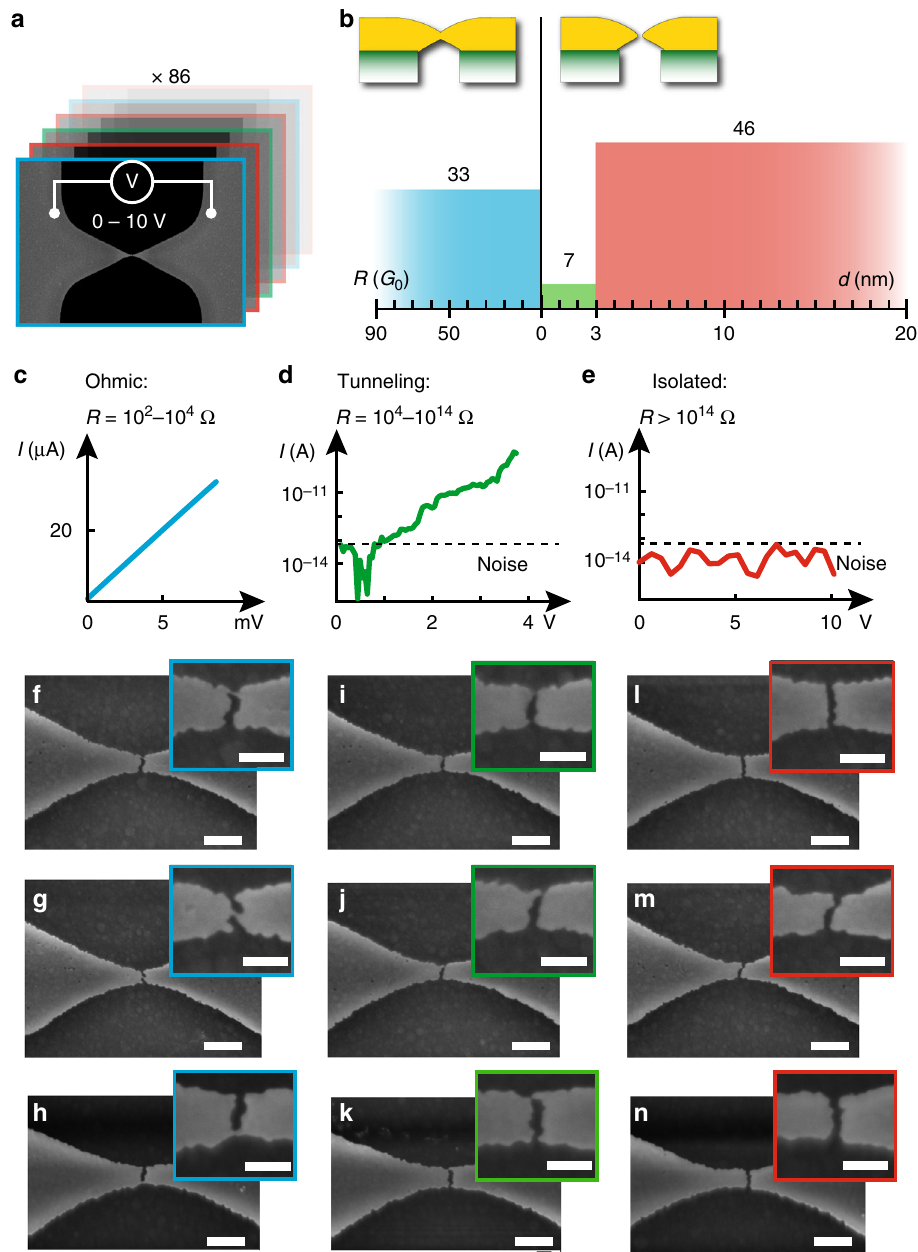
Fig. 4 Classifying junctions using electrical characterization and SEM imaging. a Schematic of two probe electrical characterization, and b the collected results of the electrical characterization of 86 nominally identical junctions featuring an initial bridge length of L = 3.3 µ m and a 90 nm wide constriction. Due to the stochastic breaking of the strained gold at the crack-lines of each of the 86 junctions, the resulting gold electrodes were either connected by one or two unbroken ligaments of total resistance R , or separated by gaps of widths d . Of the 86 junctions, 33 junctions showed ohmic behavior with at least one connected ligament, 46 junctions showed electrically isolated electrodes which could also be con fi rmed by visual inspection, and seven junctions showed tunneling I – V characteristics thereby revealing gold ligaments that have broken and formed a sub-3 nm gap. c – e Representative I - V characteristics of the three outcomes: ohmic, tunneling and isolated. f – n SEM images of three representative probed junctions for each of the three outcomes: ohmic ( f – h ), tunneling ( i – k ), and isolated ( l – n ) are shown. These SEM images illustrate the strong correlation found between the electrical characterization performed ‘ blind ’ , without prior visual inspection of the junctions, and the morphology of the junctions revealed by SEM imaging. Scale bar is 200 nm for f